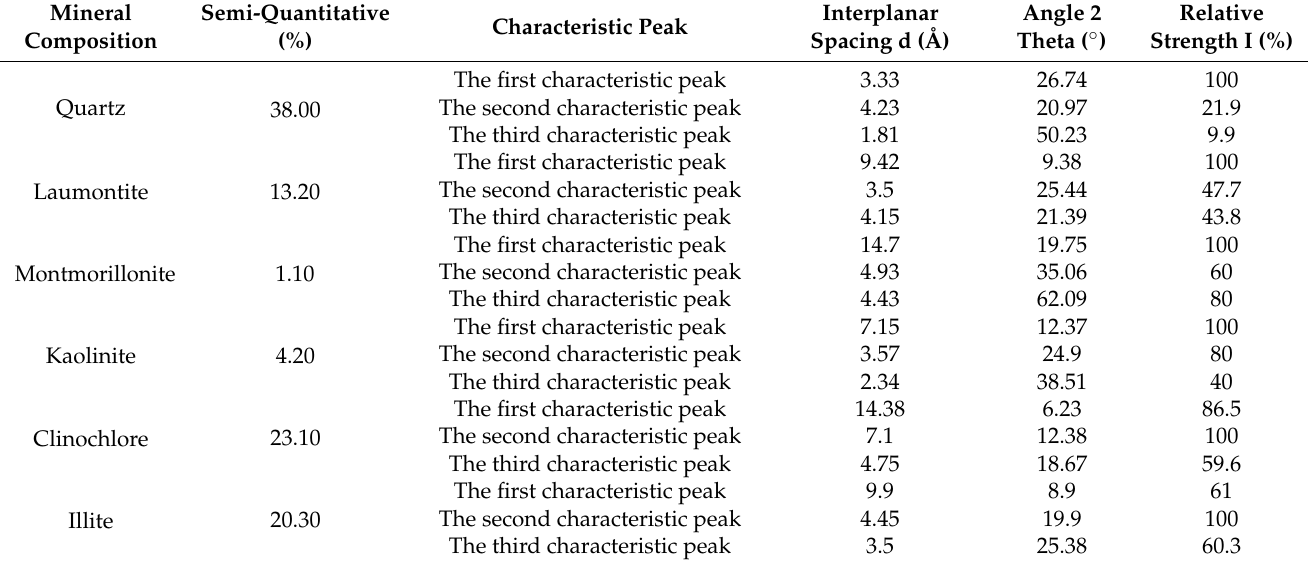
Figure 2. X-ray diffraction spectrum. Table 3. Mineral composition of red clay.